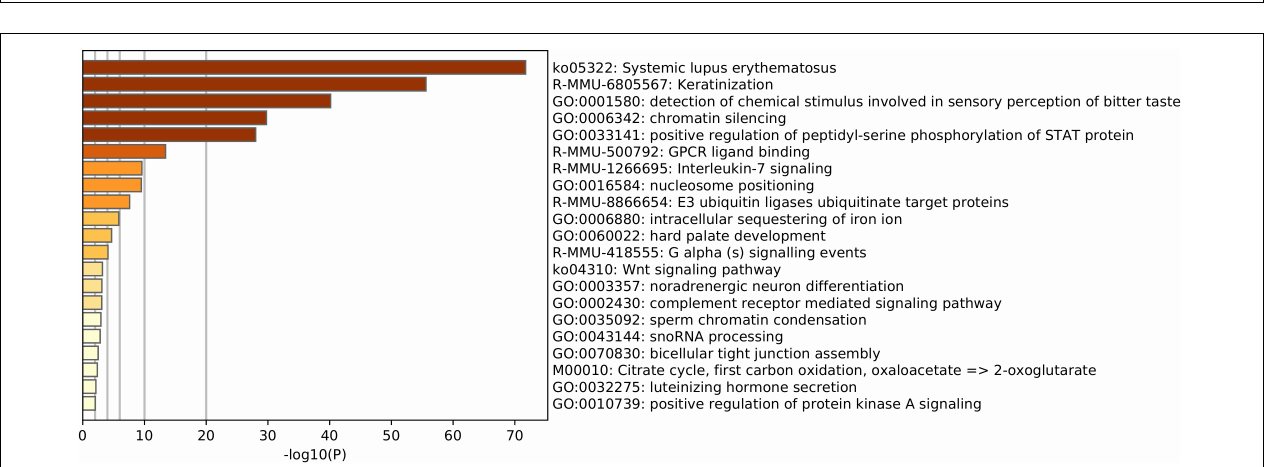
FIGURE 4 | Functional enrichment of mouse IG proteins. Gene ontology enrichment and pathways for IG proteins. The color key from yellow to brown indicates high to low p -values, respectively.